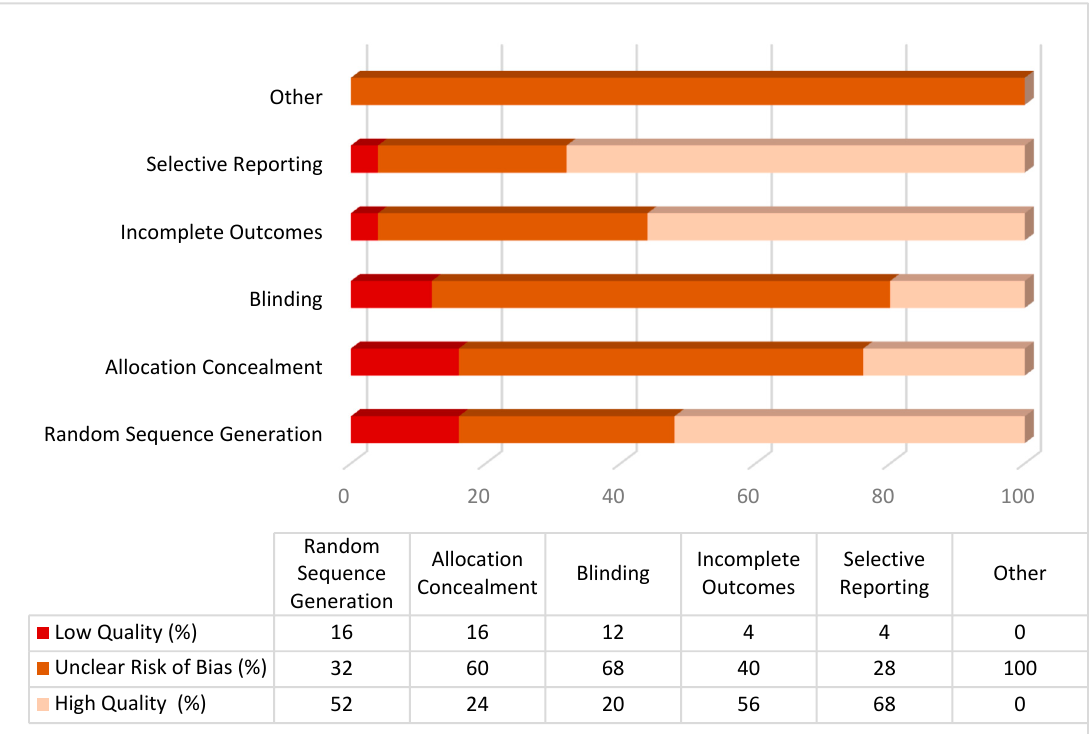
Figure 2. Qualitative assessment (% of studies for each condition of risk of bias).